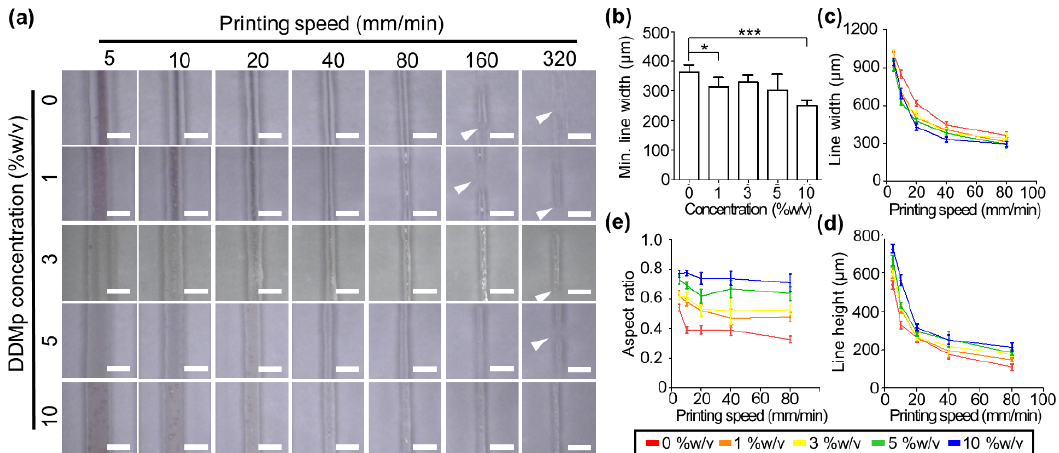
Figure 5. Printability test of DDMp bio-inks. ( a ) Microscopy image of line patterns printed with DDMp bio-inks according to the change of printing speed (scale bar: 1 mm). White arrows indicate disconnected points in the printed lines. Measured results of printable minimum (min.) line width ( b ), line width (* p < 0.05; *** p < 0.001), ( c ) and height ( d ) of the printed lines ( n = 10). Min. line width refers to the smallest width among continuous line patterns printed without breaking. ( e ) Aspect ratios of the printed lines, which were calculated using the measured line widths and